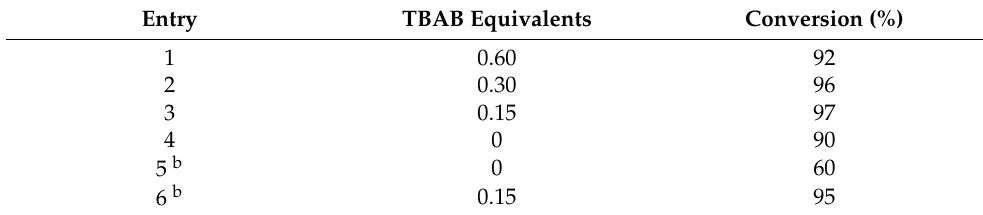
Table 4. Role of the phase-transfer catalyst in the reaction a